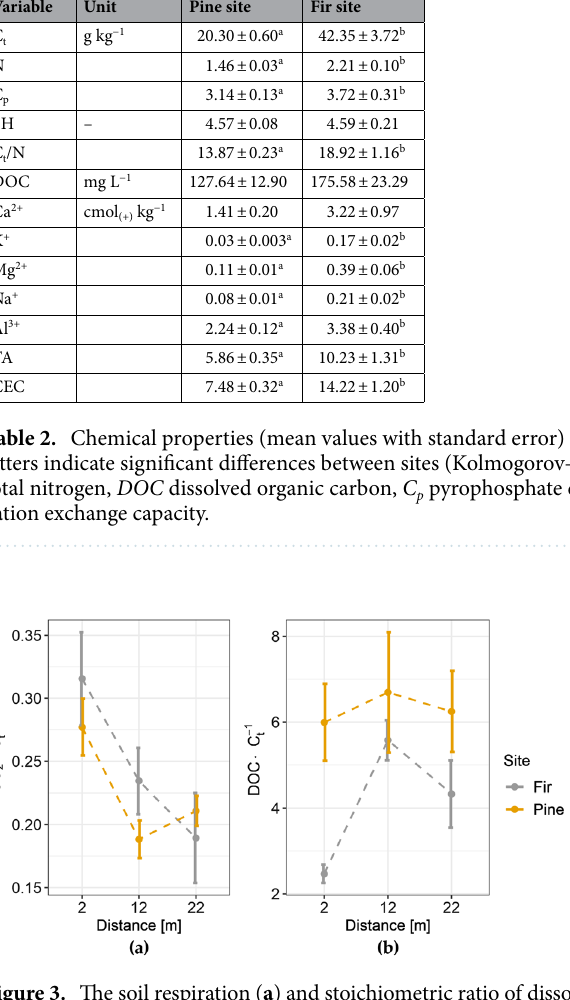
Figure 3. The soil respiration ( a ) and stoichiometric ratio of dissolved organic carbon (DOC) to total carbon (C t ) ( b ), plotted against the distance from the forest edge. The circle represents the mean; the whiskers indicate the standard